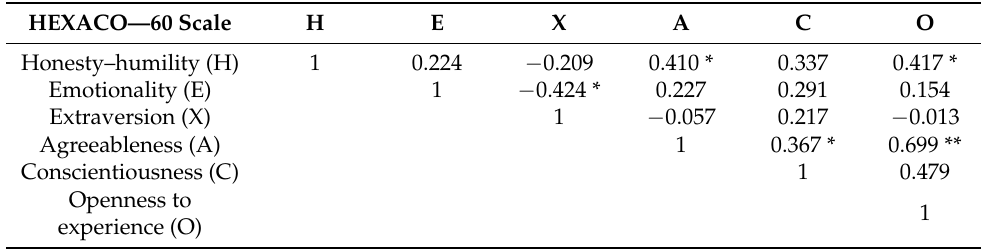
Table 2. Correlations between the HEXACO-60 scales in self report.